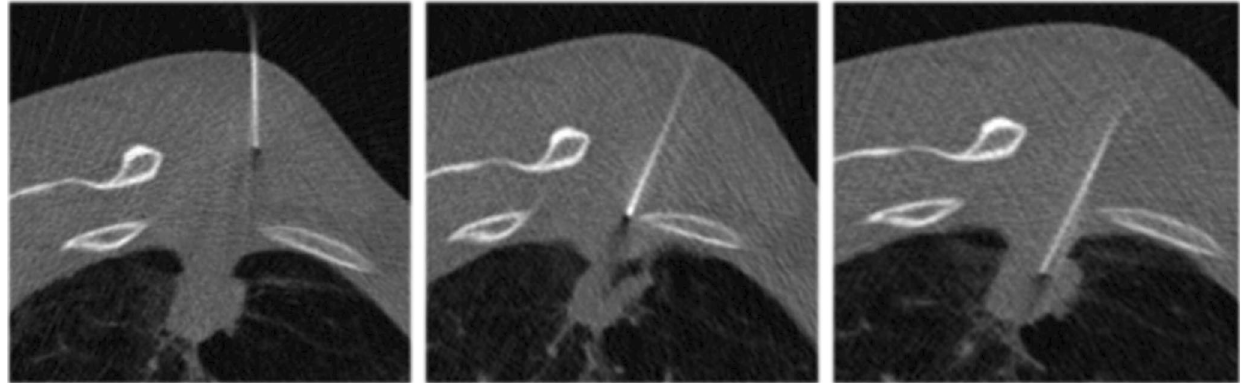
Fig. 4 Axial images during fluoroscopy-guided chest biopsy of a solitary subpleural